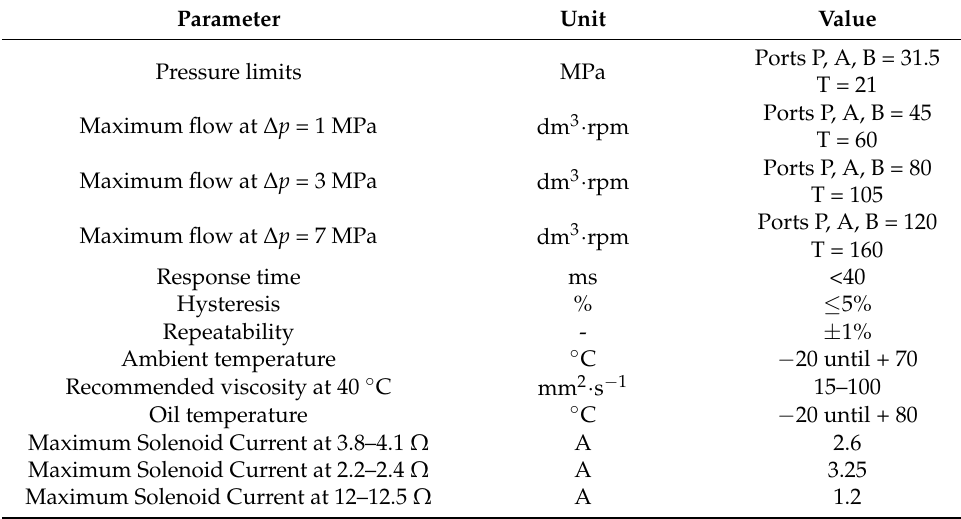
Table 11. Technical parameters of the proportional valve DKZOR-A